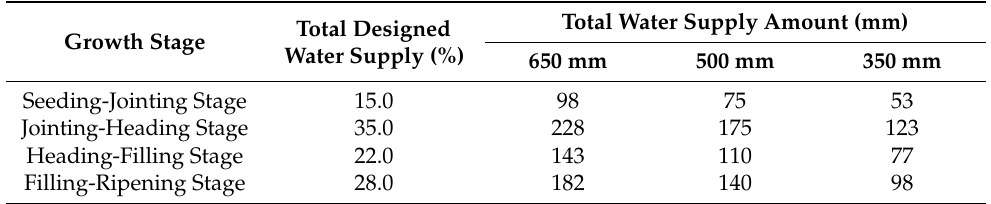
Table 2. The designed water supply scheduling in different growth stages for treatment MD, DD, and